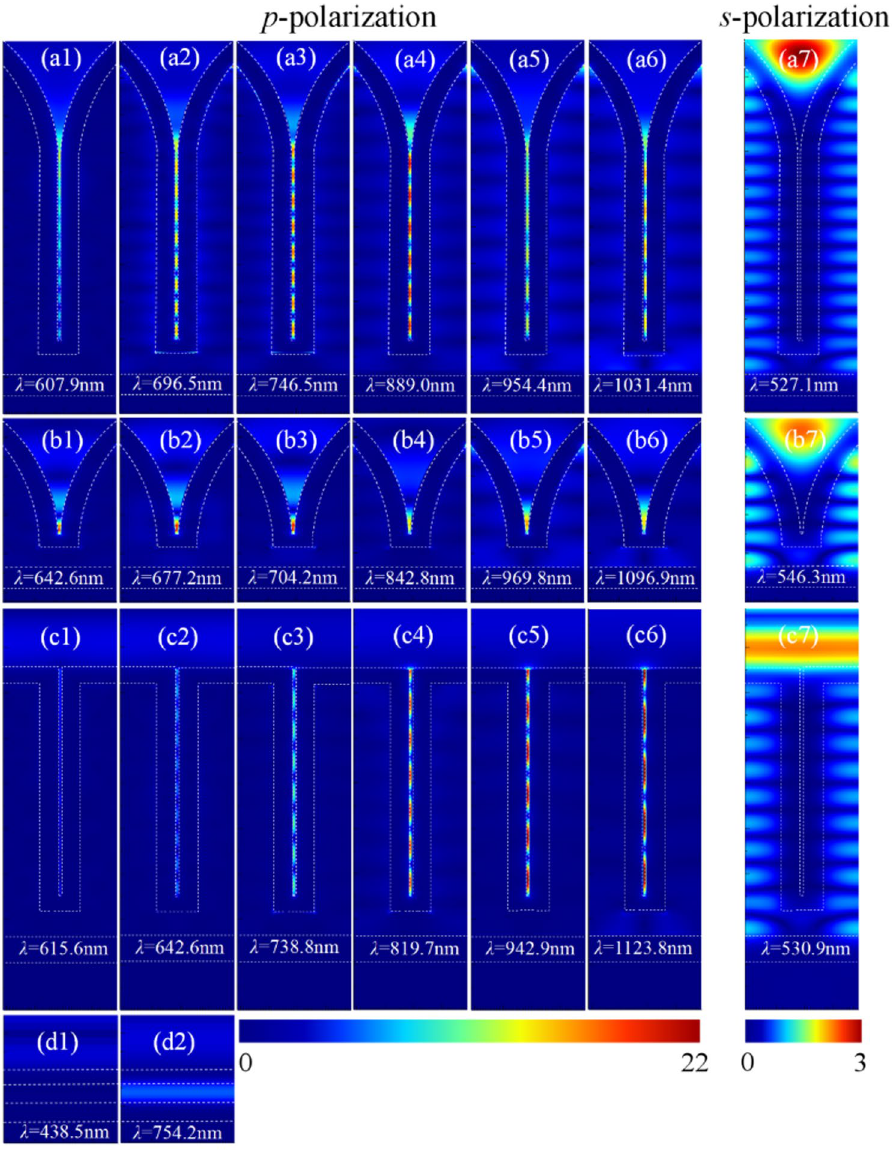
Figure 3. Distributions of the amplitude of electric field for p -polarization at some representative absorption peak wavelengths for our hot-carrier solar cell based on the combined structure of capped nanowires with top nanocones (the first row): ( a1 ) λ = 607.9 nm, ( a2 ) λ = 696.5 nm, ( a3 ) λ = 746.5 nm, ( a4 ) λ = 889.0 nm, ( a5 ) λ = 954.4 nm, ( a6 ) λ = 1031.4 nm; the solar cell based on the nanocones only (the second row): ( b1 ) λ = 642.6 nm, ( b2 ) λ = 677.2 nm, ( a3 ) λ = 704.2 nm, ( a4 ) λ = 842.8 nm, ( a5 ) λ = 969.8 nm, ( a6 ) λ = 1096.9 nm; the solar cell based on the nanowires only (the third row): ( c1 ) λ = 615.6 nm, ( c2 ) λ = 642.6 nm, ( c3 ) λ = 738.8 nm, ( c4 ) λ = 819.7 nm, ( c5 ) λ = 942.9 nm, ( c6 ) λ = 1123.8 nm; and the planar cell (the bottom row): ( d1 ) λ = 438.5 nm, ( d2 ) λ = 754.2 nm. Distributions of the amplitude of electric field for s -polarization ( a7 ) at λ = 527.1 nm for our hot-carrier solar cell, ( b7 ) at λ = 546.3 nm for the cell based on the nanocones only, and ( c7 ) at λ = 530.9 nm for the cell based on the nanowires only,